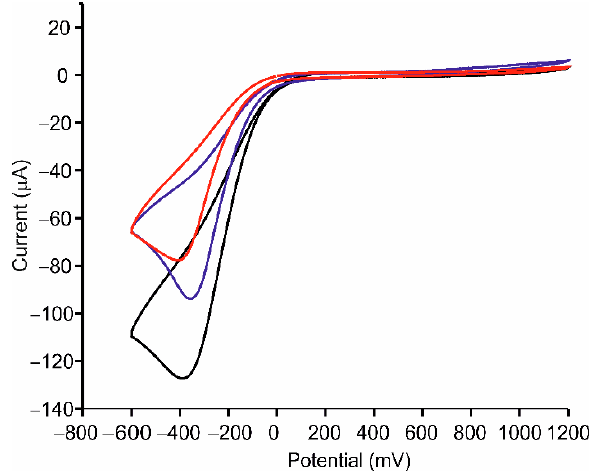
Figure 6. Voltammetric response in catechol 10 − 4 mol·L − 1 in 0.01 mol·L − 1 PBS, pH 7.0 of ITO-Tyr (red), AgNPs-Tyr (blue) and AgNWs-Tyr (black).